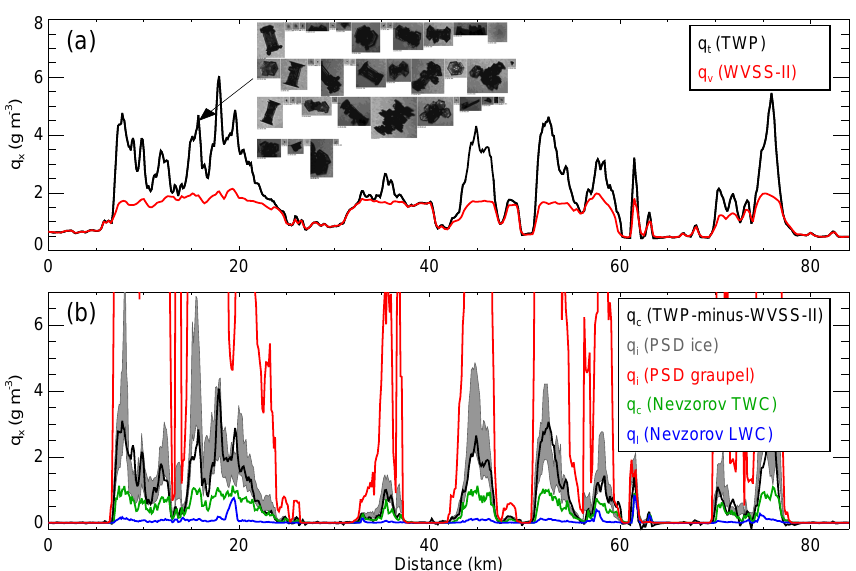
Figure 2. Example data from cumulus cloud penetrations made during flight B667 at a temperature of − 14.4 ◦ C. Panel (a) shows the measured q t from the total water probe and q v from the WVSS-II instrument. Example CPI imagery is also shown. Panel (b) shows the q c measured by the Nevzorov probe and from the TWP-minus-WVSS-II method. Also included are measurements of the liquid water content from the Nevzorov q l sensor. The grey shading shows a range of q i estimates from integration of the measured PSD using a selection of M – D relations for ice, and the red line shows an estimate of q i using a M – D relation for graupel (see Table 1).